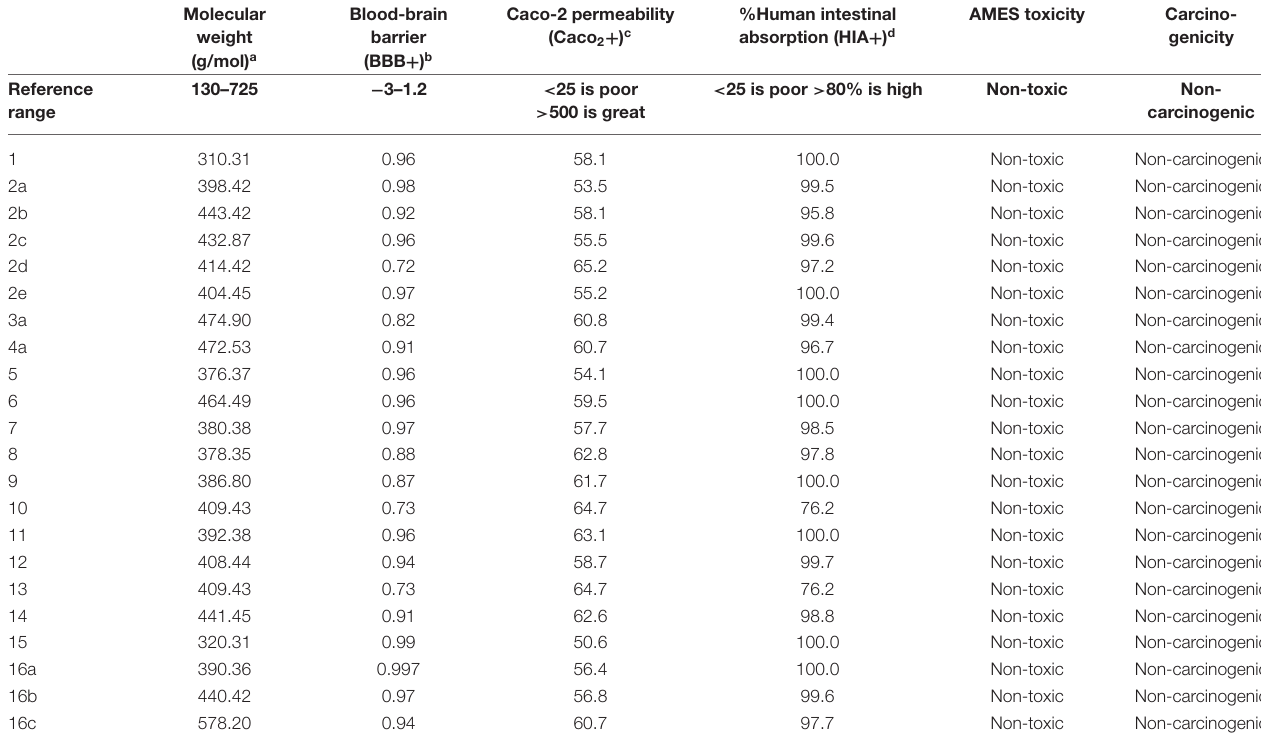
TABLE 2 | List of ADMET properties of synthesized hybrid molecules 1-16. Molecular